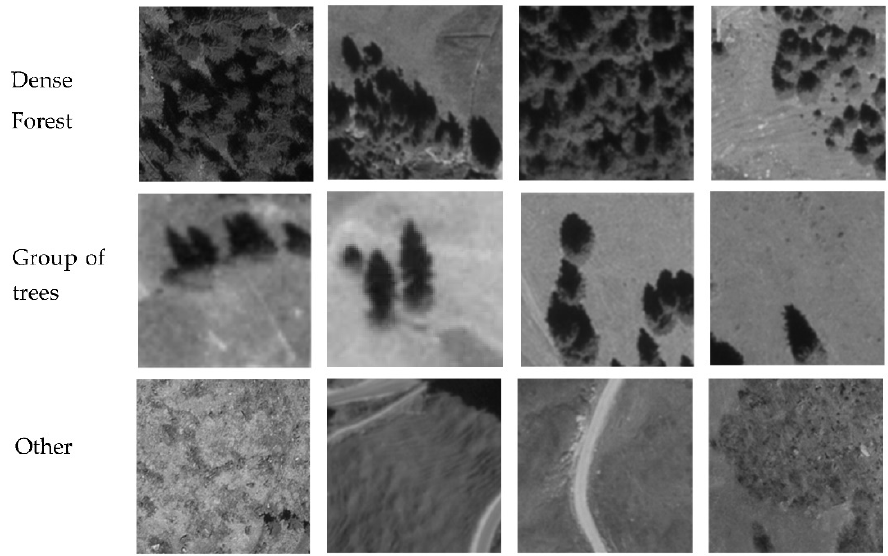
Figure 7. Examples of image patches (50 × 50 m) from time point T1 (1980) of the three different structure classes “dense forest”, “group of trees”, and “other” for parts of study area 1.